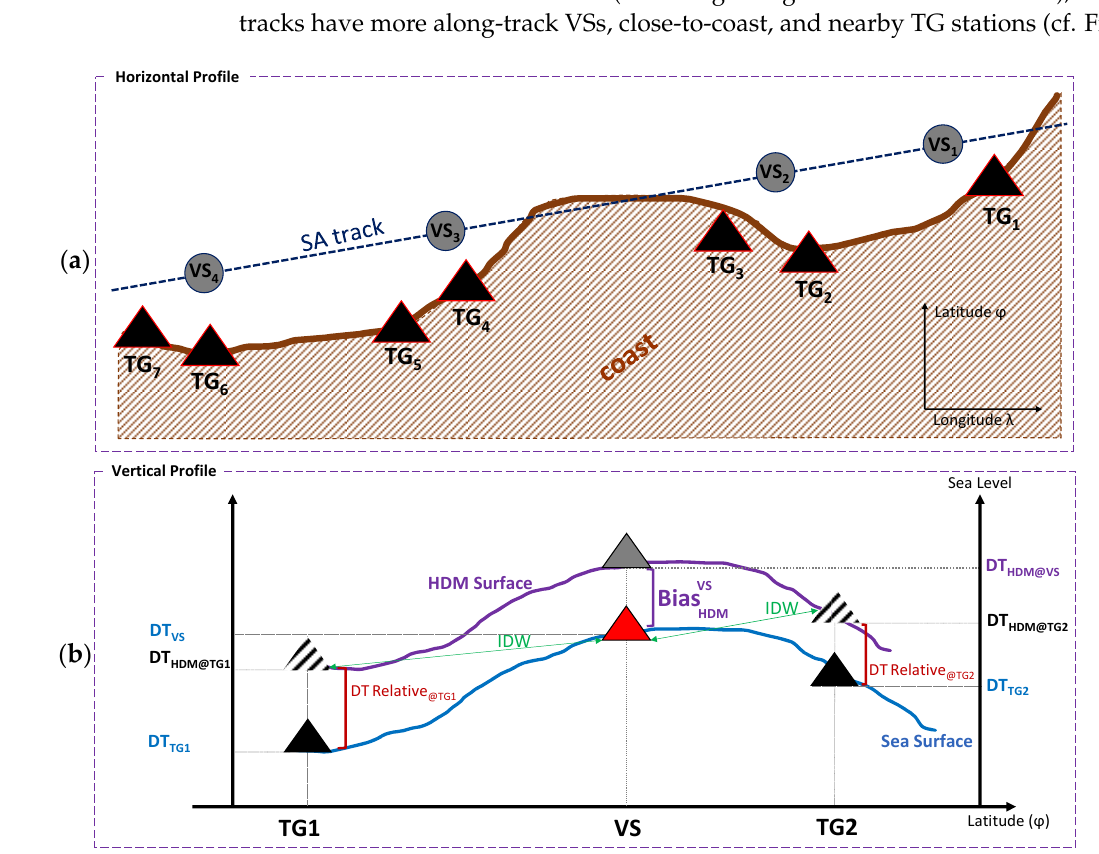
Figure 2. Determination of the HDM bias and selection principles of virtual stations (VSs). ( a ) The horizontal pro fi le of a single SA pass and selection of VSs along the SA track near TG locations. ( b ) Determination of the HDM bias at the location of VS ( 𝐵𝑖𝑎𝑠 (cid:3009)(cid:3005)(cid:3014)(cid:3023)(cid:3020) ) using the 𝐷𝑇 (cid:3021)(cid:3008) by adding the rela- tive DT .